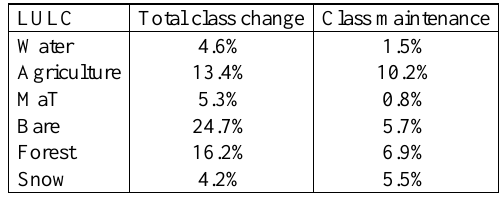
Figure 5. Sankey diagram for the specific LULC change. The left column is for the year 1999, while the right column corresponds to 2019.